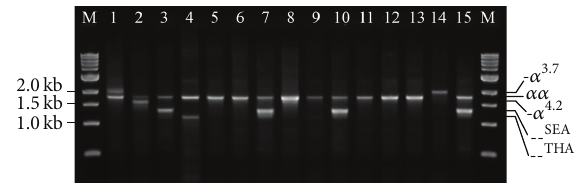
Figure 1: Representative 1.5% agarose gel electrophoresis of the amplified PCR products for characterizing 𝛼 -globin gene deletion types by multiplex gap PCR. The 2 kb, 1.8kb, 1.6kb, 1.4kb and 1.2 kb represent 3.7 kb deletion fragment (- 𝛼 3.7 ), normal fragment ( 𝛼𝛼 ), 4.2 kb deletion fragment (- 𝛼 4.2 ), SEA type deletion